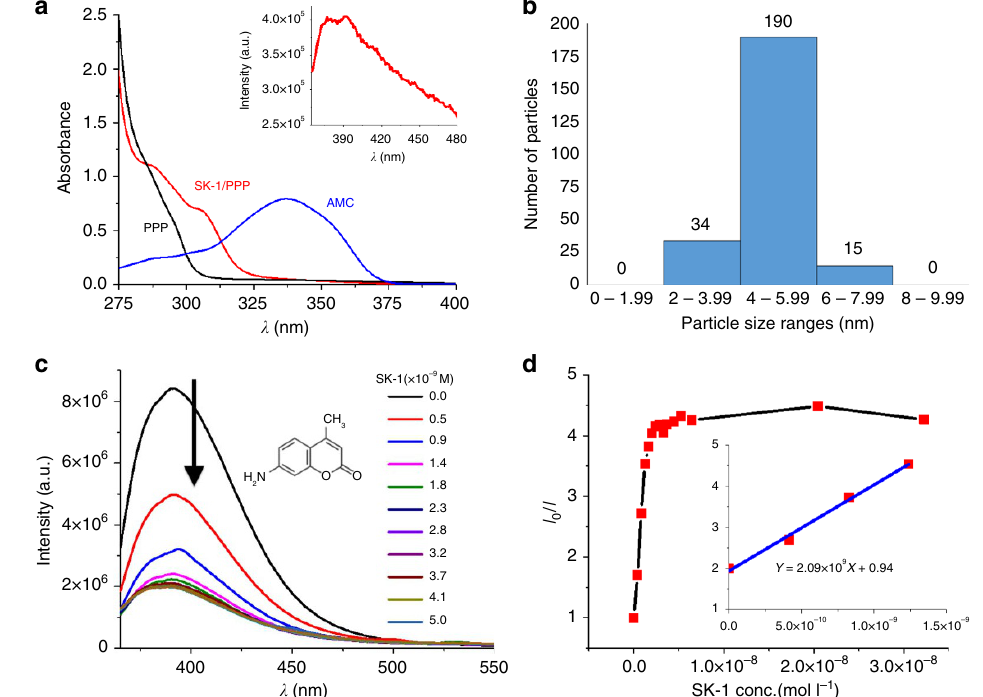
Figure 6 | Particle-size distribution and solution behaviour of SK-1 cages in CHCl 3 . ( a ) UV-vis spectra of PPP in CHCl 3 ([PPP] B 1 (cid:4) 10 (cid:3) 5 M, black line), SK-1/PPP in CHCl 3 ([SK-1] B 2 (cid:4) 10 (cid:3) 5 M, [PPP] B 7.5 (cid:4) 10 (cid:3) 4 M, red line) and 7-amino-4-methylcoumarin (AMC) in CHCl 3 ([AMC] B 1 (cid:4) 10 (cid:3) 5 M, blue); ( a ) inset Fluorescence spectrum of SK-1/PPP in CHCl 3 ([SK-1] B 2 (cid:4) 10 (cid:3) 6 M, [PPP] B 7.5 (cid:4) 10 (cid:3) 5 M, l ex ¼ 338nm); ( b ) Particle-size distribution (measured from Fig. 5e); ( c ) Fluorescence titrations characterizing the host–guest interactions between 7-amino-4-methylcoumarin (AMC) and the coordination cages ( l em_max ca. 391nm; l ex ¼ 338nm); Fluorescence quenching when aliquots of a SK-1/PPP solution in CHCl 3 ([SK-1] B 2 (cid:4) 10 (cid:3) 7 M, [PPP] B 7.5 (cid:4) 10 (cid:3) 6 M) are added to an AMC solution in CHCl 3 (1 (cid:4) 10 (cid:3) 7 M). ( d ) Stern–Volmer plots ( l em ¼ 391nm; l ex ¼ 338nm) that are characteristic for static quenching and indicating binding (see inset) between the coordination cages and